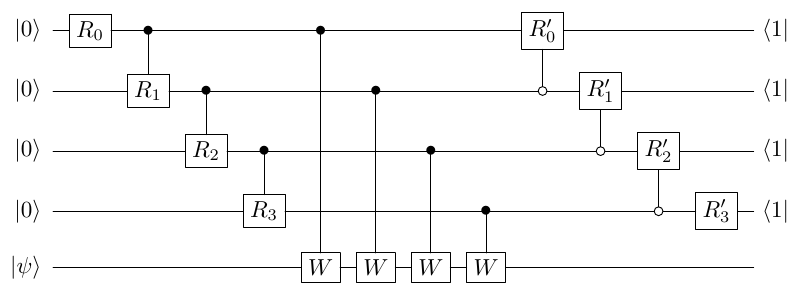
FIG. 5. A linear combination of steps using control registers prepared in unary using a linear sequence of controlled rotations but with the inverse preparation performed with the linear sequence in the reverse order.